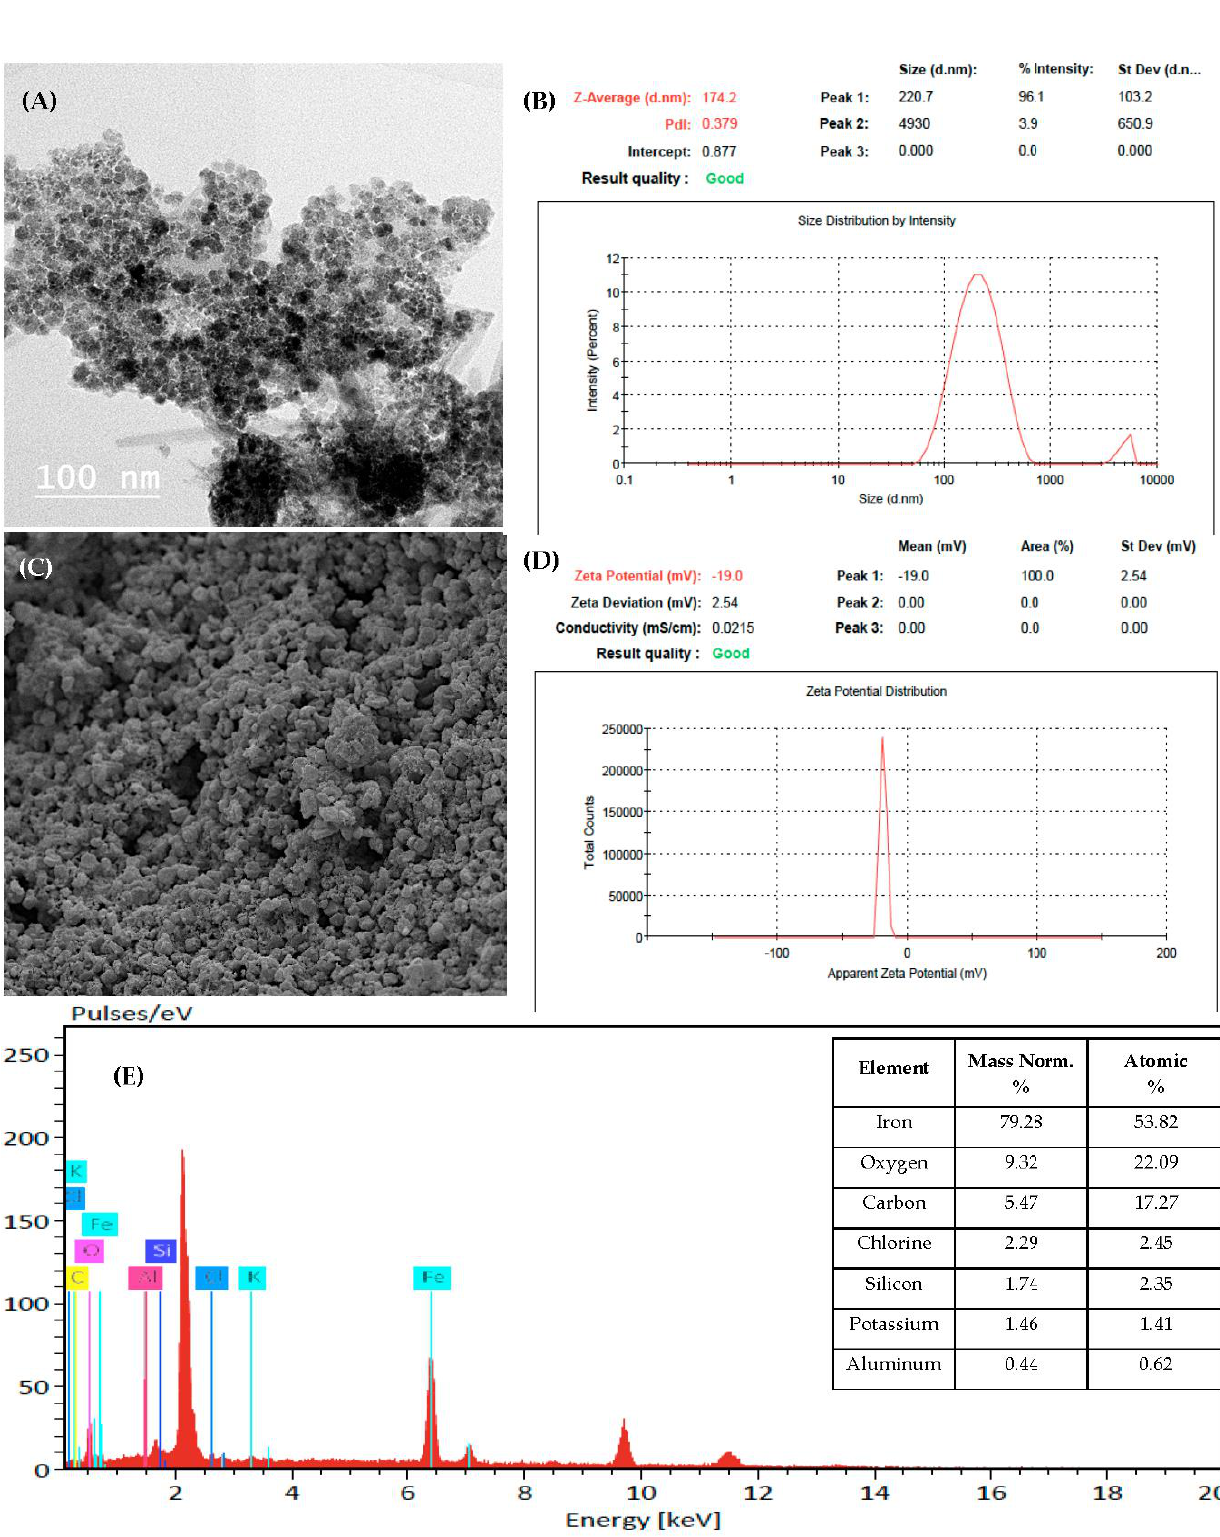
Figure 1. TEM image ( A ), Zeta average diameter ( B ), SEM image ( C ), Zeta potential ( D ) and EDX profile of Fe 3 O 4 /HA NPs ( E